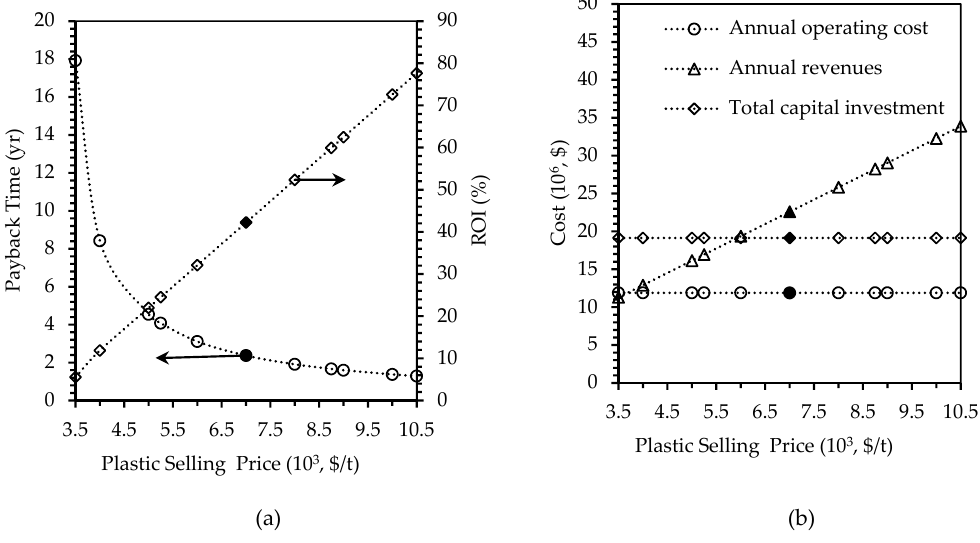
Figure 6. Effects of changing plastic selling price, on ( a ) payback time in years and ROI in percent, and ( b ) annual operating cost, annual revenues, and total capital investment in U.S. dollars. Filled markers represent results of the base case scenario.